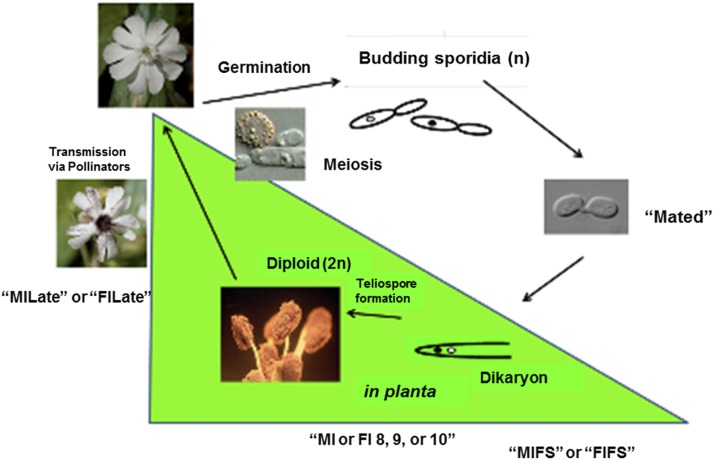
Conditions/stages of M. lychnidis-dioicae–S. latifolia system examined by RNA-Seq. In planta stages of the interaction were examined by RNA-Seq to analyze differentially expressed fungal and host genes at each stage. For fungal analyses, differential expression was compared, in most cases with the in vitro condition of mated haploid sporidial cells (“Mated”), MIFS or to FIFS. MIFS, infected male S. latifolia floral stem; FIFS, infected female S. latifolia floral stem; MI or FI 8, 9, or 10, infected male (MI) or female (FI) S. latifolia buds at the respective developmental stage indicated (Toh and Perlin 2015); MILate or FILate, infected male or female flowers, respectively, in the late stages of infection, where opened flowers show visible teliospores. Additional conditions not shown: MU, uninfected male plants; FU, uninfected female plants; MIFI designations in the text refer to RNA-Seq data pooled for male and female infected plants for a given condition for Gene Enrichment Analysis (e.g., MIFIFS). This figure was adapted, with permission, from our previously published work (Figure 1; Perlin et al. 2015).